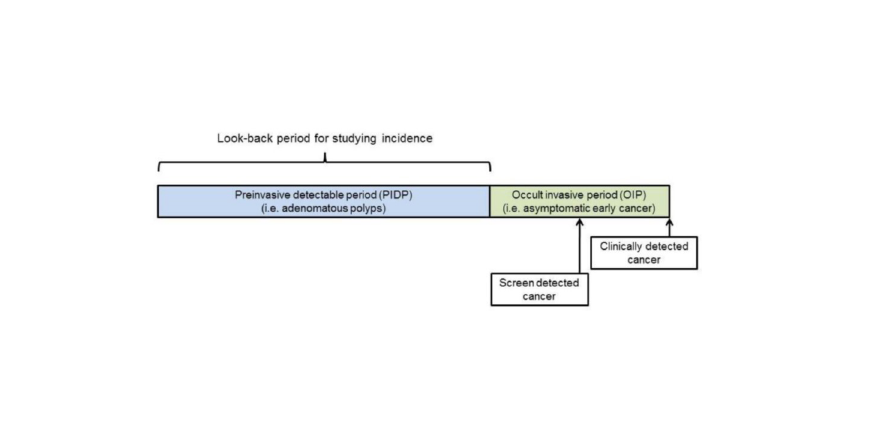
Fig 1. Look-back periods for evaluating screening and colorectal cancer